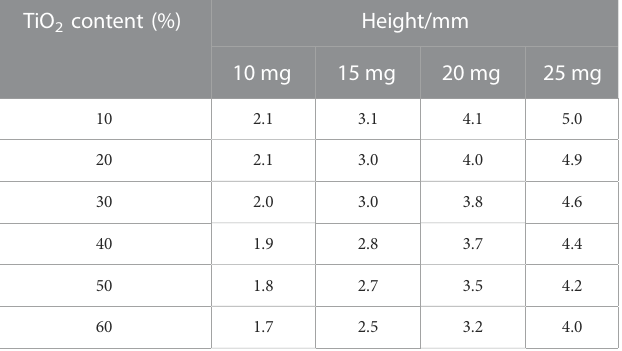
TABLE 3 Experimental conditions for the minimum ignition energy of iron particles.